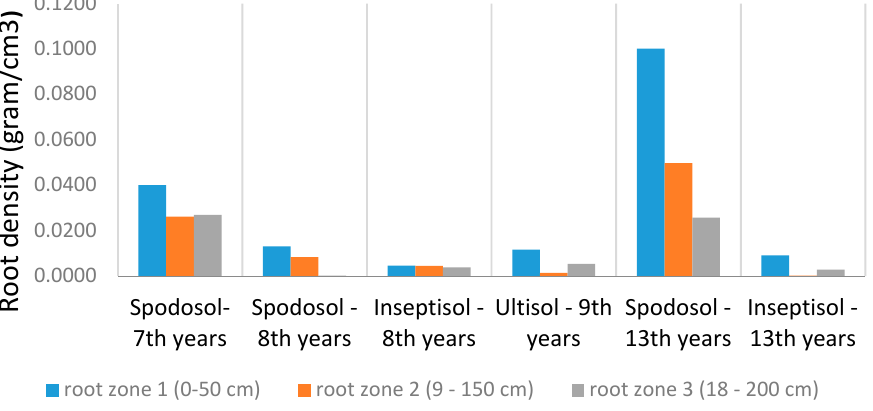
Figure 2. The distribution of oil palm root density under varying soil type and crop age.